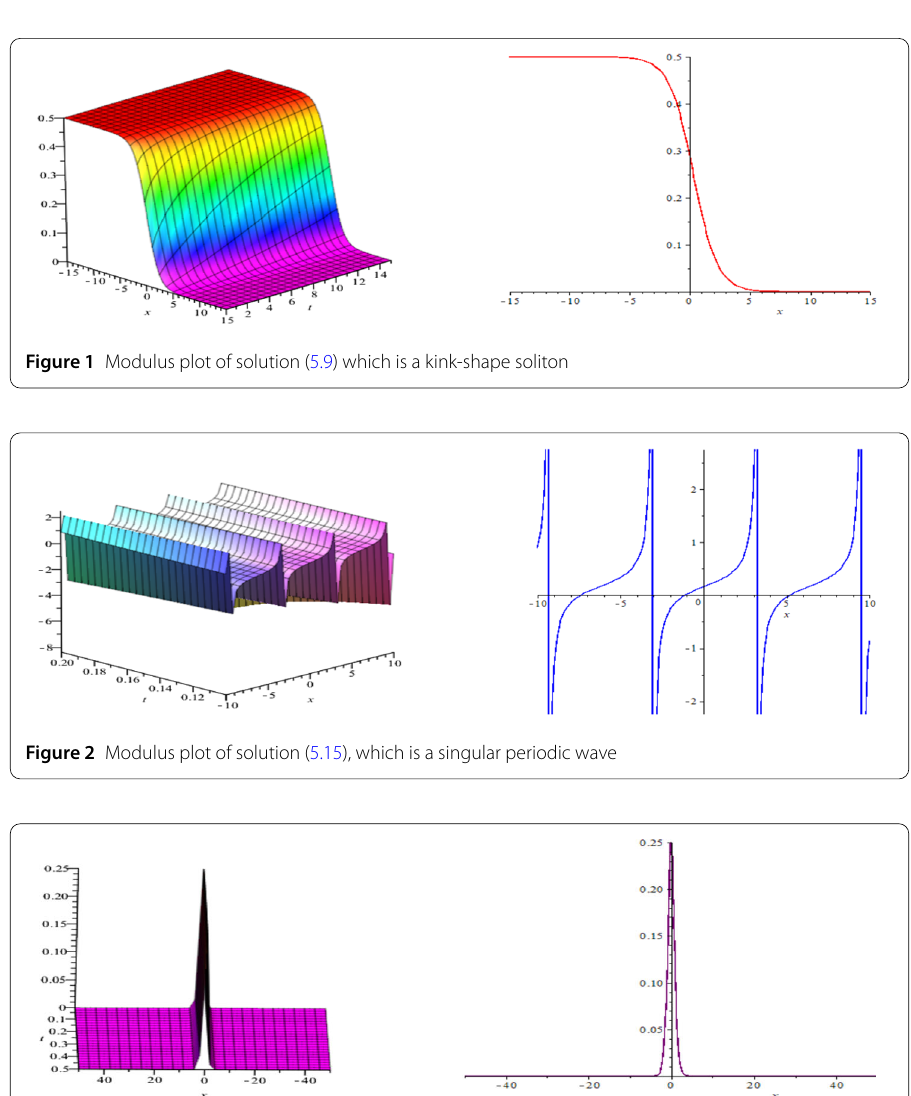
ξ = x – 2 t 0.5 with fractional order α = 0.5 and is plotted in Fig. 5 within the limits –100 ≤ x ≤ 100 and 0.1 ≤ t ≤ 1. Solution (5.64) represents the bell-shape soliton for λ = –1, b 1 = 1, A 2 = 1, w = 1, ξ = x – 20 t 0.95 with fractional order α = 0.95 and outlined in Fig. 6 within the 19 range –5 ≤ x ≤ 5 and 0.1 ≤ t ≤